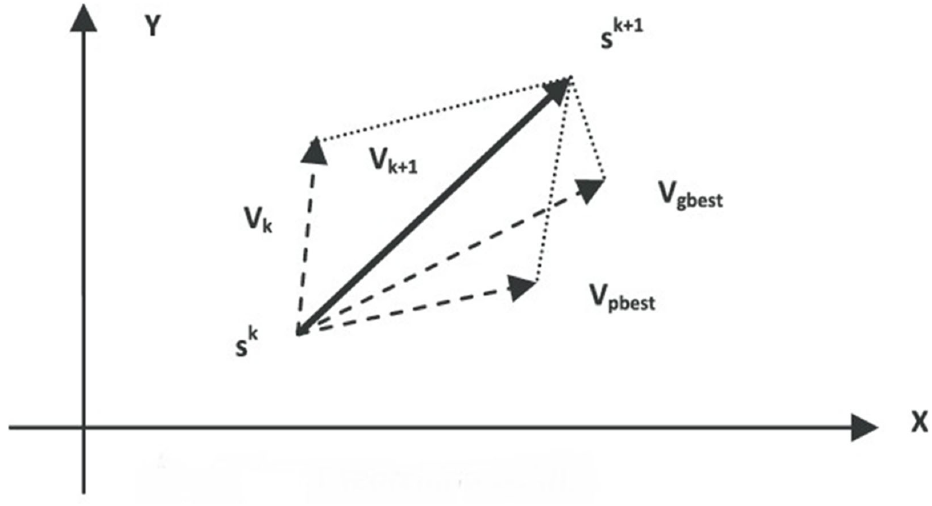
Figure 1. PSO searching point changing mechanism. Where s k represents current searching position, v k represents current velocity, s k+1 represents new modified searching position, v k+1 represents new modified velocity, V pbest represents velocity with care of pbest, and V gbest represents velocity with care of gbest. Thus, all particles update their position based on main four parameters: (1) the current position, (2) the current velocity, (3) the distance between the current position and pbest, and (4) the distance between the current position and gbest. The main architecture of PSO is shown in Figure